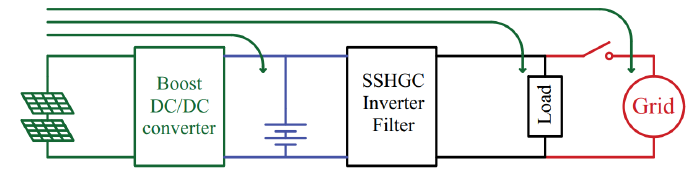
Figure 8. Power operation mode 5.